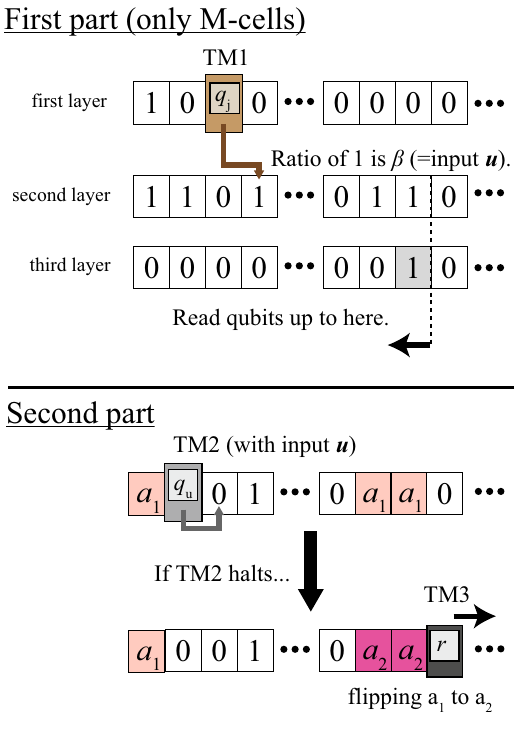
Fig. 2 Roles of three layers in M-cells and schematic of dynamics of two Turing machines. [Top]: In the fi rst part, a Turing machine, TM1, decodes a bit sequence u on the fi rst layer through the estimation of the number of 1 j i